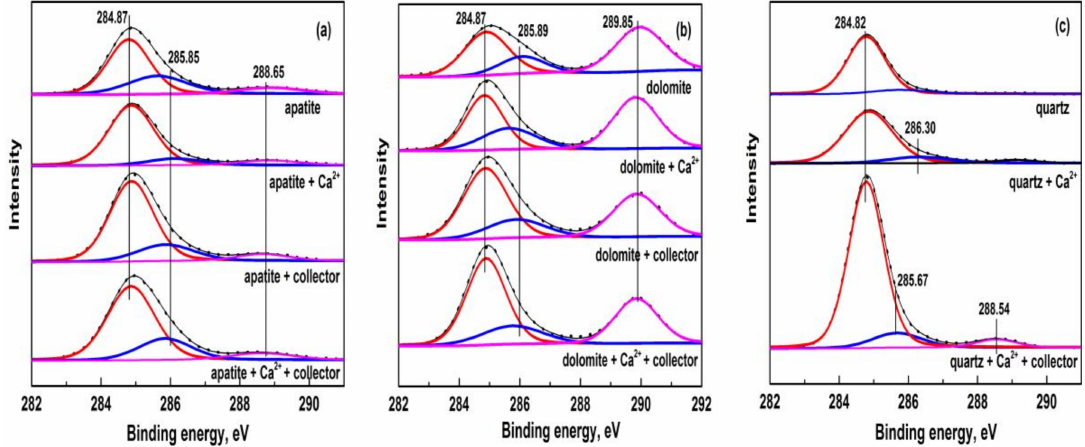
Figure 9. High resolution C1 s spectra of ( a ) apatite; ( b ) dolomite; ( c ) quartz in the absence and presence of 2.5 × 10 − 3 M Ca 2+ and 60 mg/L cottonseed oil